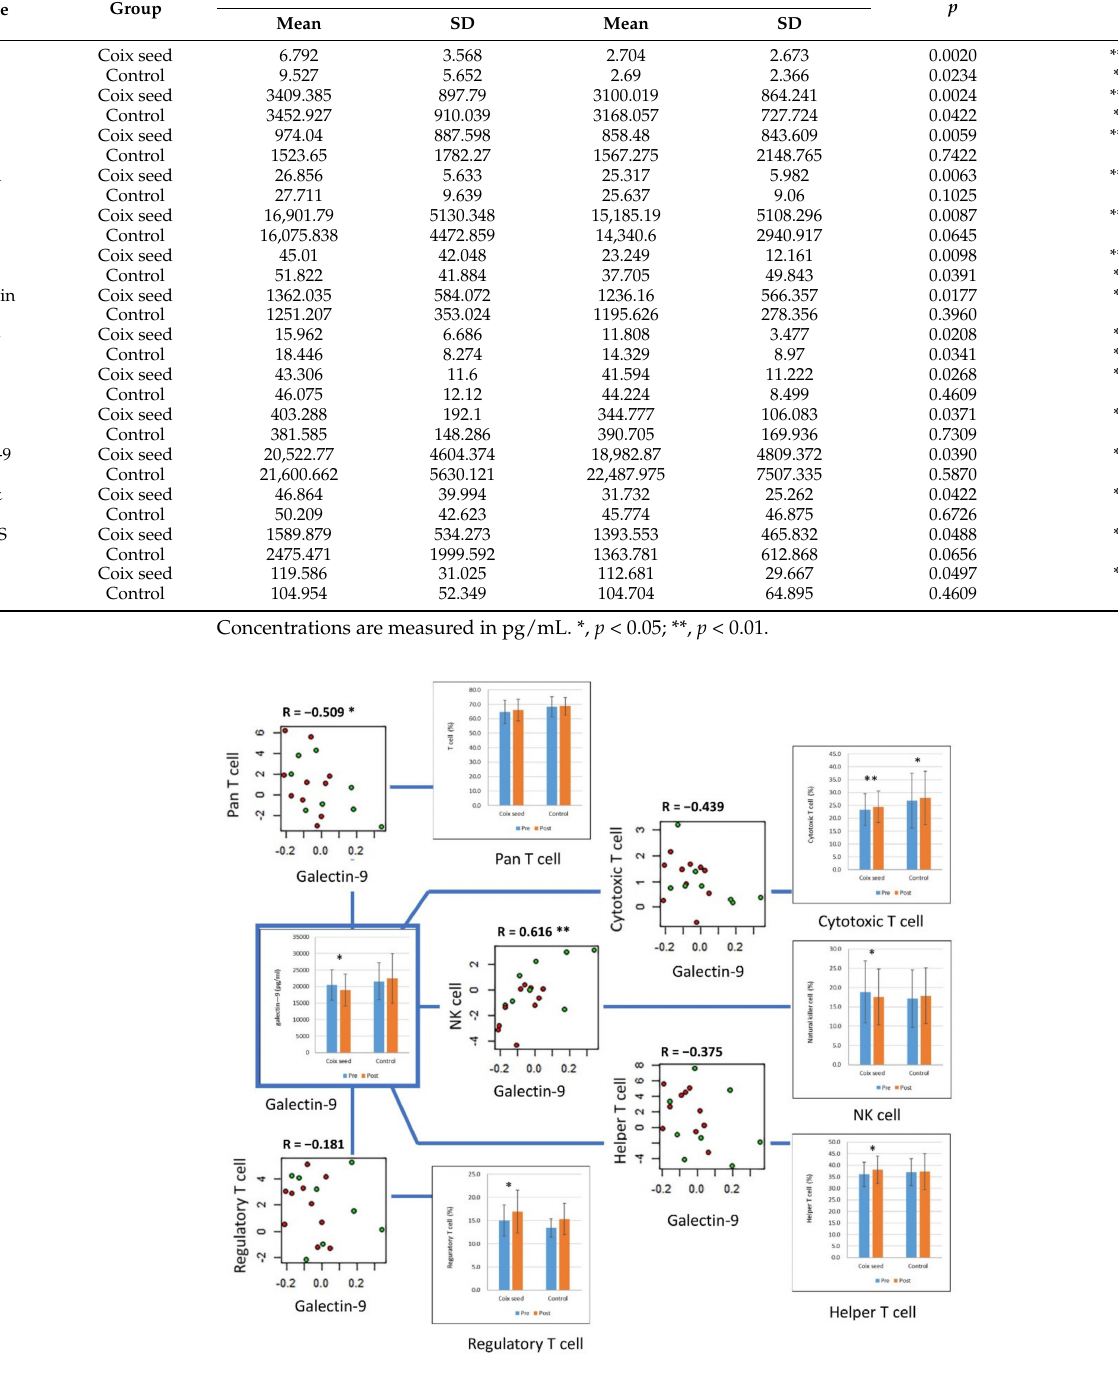
Figure 1. Galectin-9 and its correlation with peripheral lymphocyte subset percentages. The plasma concentration of galectin-9 significantly decreased after coix seed consumption. The change in galectin-9 showed a significant correlation with the changes in natural killer (NK) cell and pan T cell (CD3 + cell) percentages. The correlations between galectin-9 and cytotoxic T cells, helper T cells, and regulatory T cells are also presented. In the scatter plots, the red and green circles denote the coix seed consumption group and the control group, respectively. In the bar graphs, the blue and orange bars denote before (pre-intervention) and after (post-intervention) coix seed consumption, respectively. *, p < 0.05; **, p <